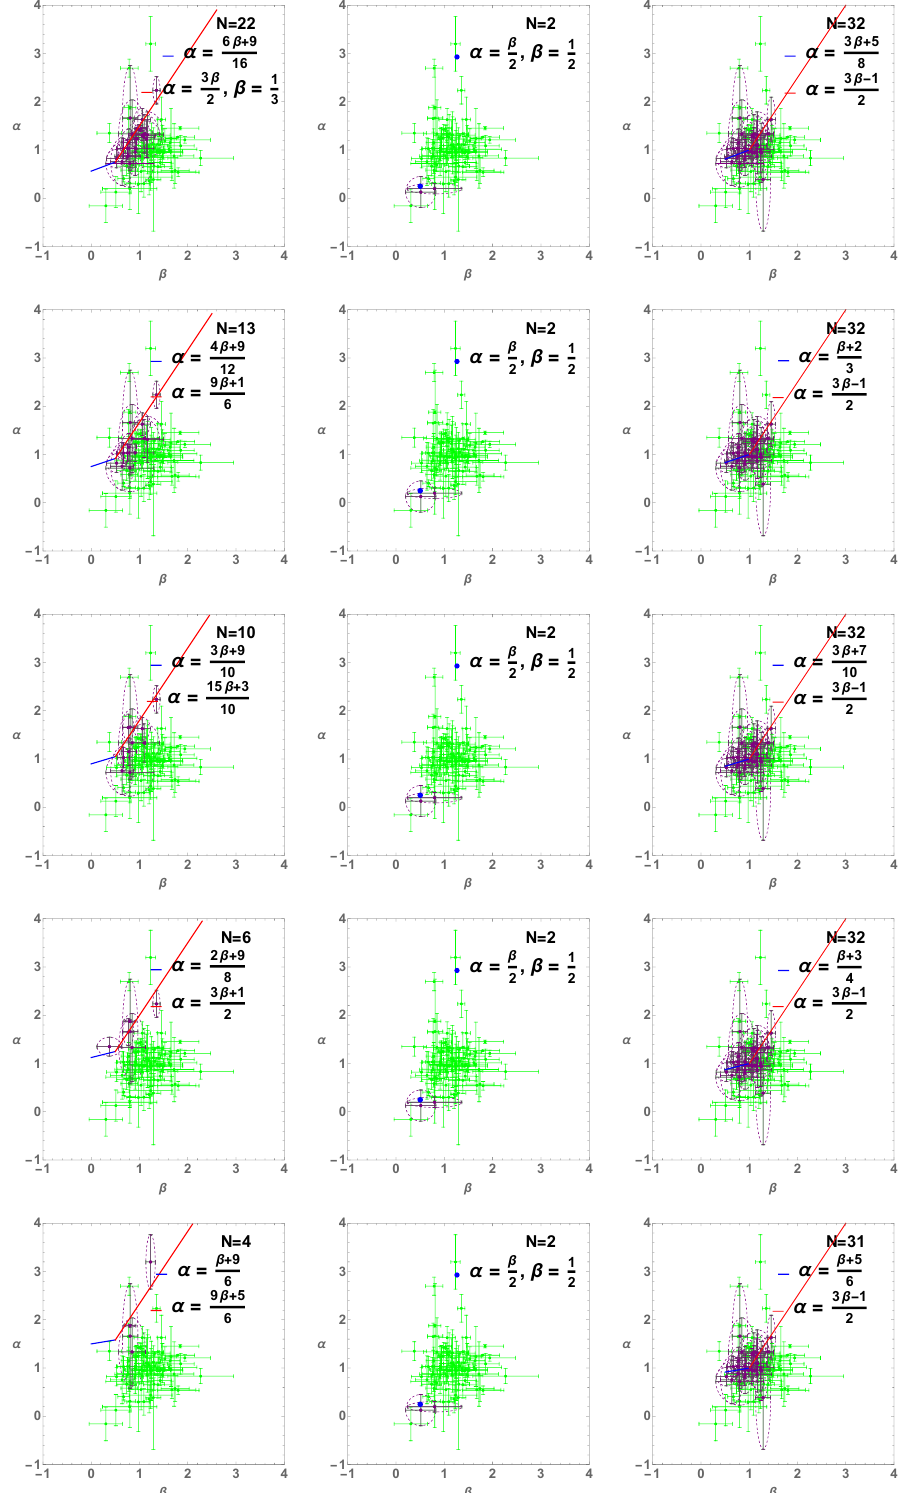
Figure 1. CRs from the FS model for k = 0,1,1.5,2, and 2.5 (top row to bottom row, respectively) without energy injection. GRBs that satisfy the relations are shown in purple; other GRBs are shown in green. The first column shows the slow-cooling, ν m < ν < ν c regime, the second column shows the fast-cooling, ν c < ν < ν m regime, and the third column shows the ν > max{ ν c , ν m }